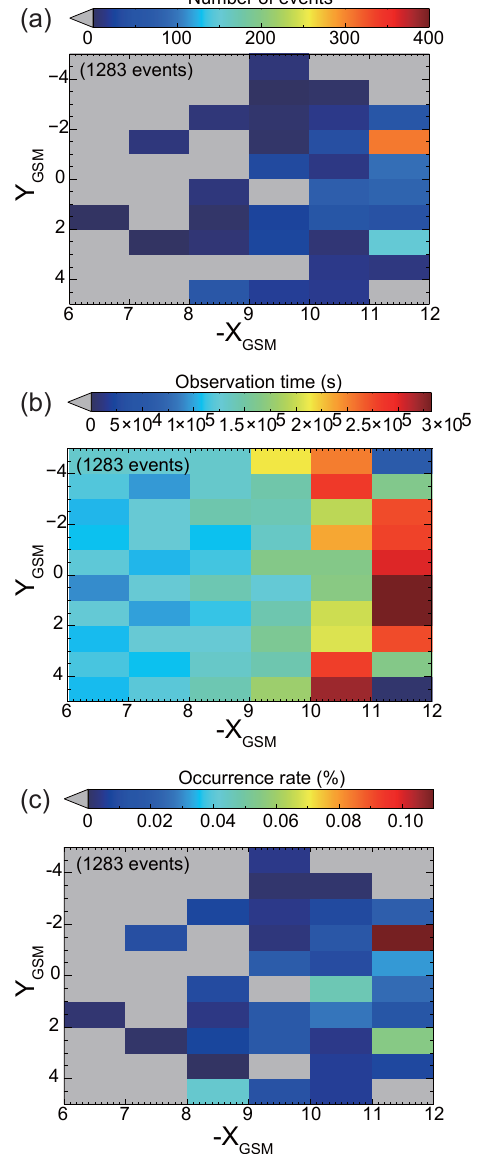
Figure 7. The spatial distributions of (a) the number of fluctuation events, (b) observation times, and (c) the occurrence rates of the fluctuation events normalized by the observation times in the GSM- X and (cid:52) Z NS plane.